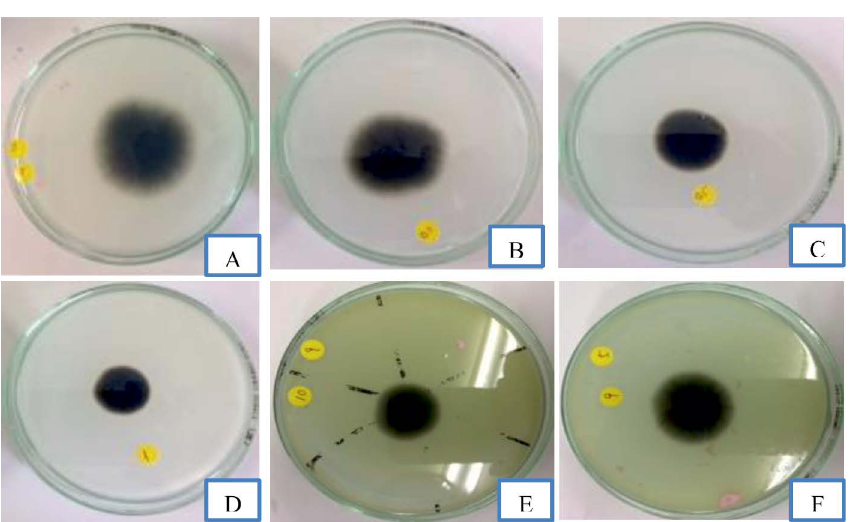
Fig. 2. Mycelia growth of Isolate 1 of P.grisea in response to control (A), 0.1 mg/mL (B), 0.5 mg/mL (C), 1 mg/mL (D), 5 mg/mL (E) and 10 mg/mL (F), repetitively of Commela communis L. extract on PDA medium.